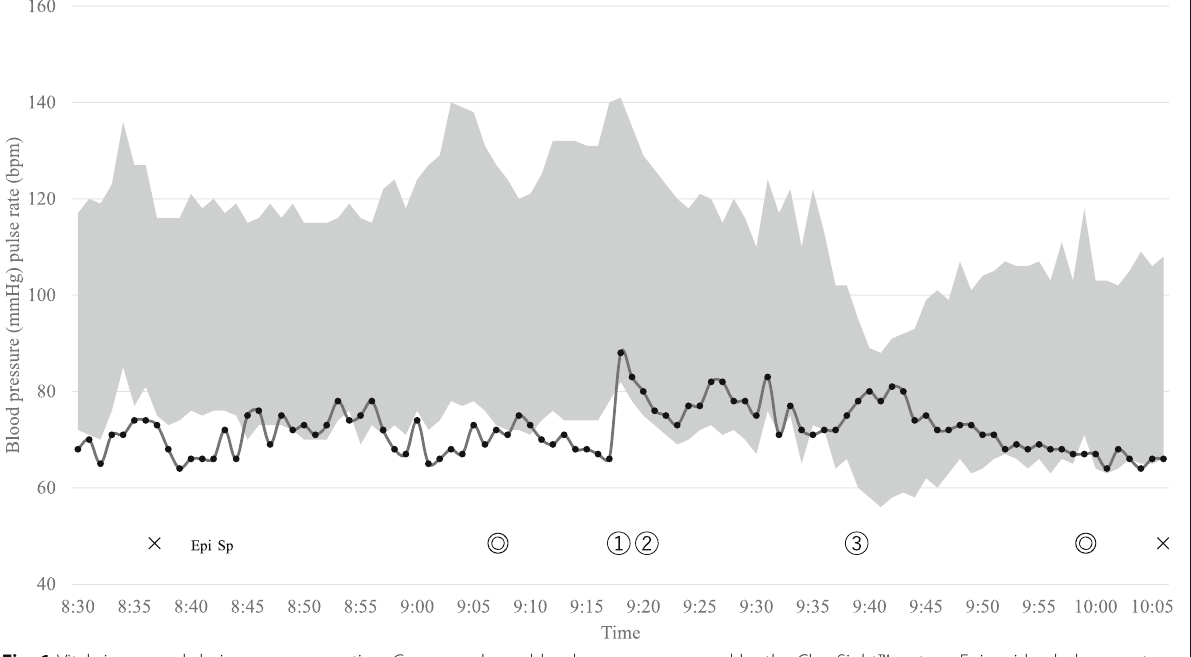
Fig. 1 Vital sign record during cesarean section. Gray area shows blood pressure measured by the ClearSight ™ system. Epi: epidural placement, Sp: spinal anesthesia induction, ● : pulse rate, × − ×: anesthesia time, ◎ – ◎ : operation time, ① : birth of the infant, ② : administration of methylergometrine 0.2mg, ③ : administration of metoclopramide